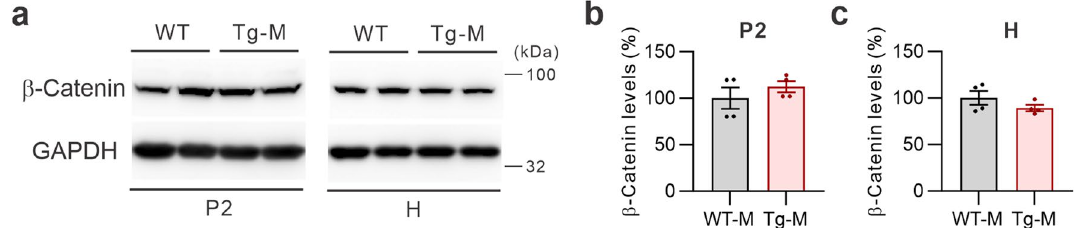
Figure 6. Total and synaptic β-catenin protein levels in S-SCAM male Tg mice. ( a ) Representative immunoblots showing β-catenin and GAPDH protein levels in the P2 ( left ) and H fractions ( right ) of male S-SCAM Tg mice. ( b , c ) Quantification of P2 ( b ) and H data ( c ). n = 4 mice per